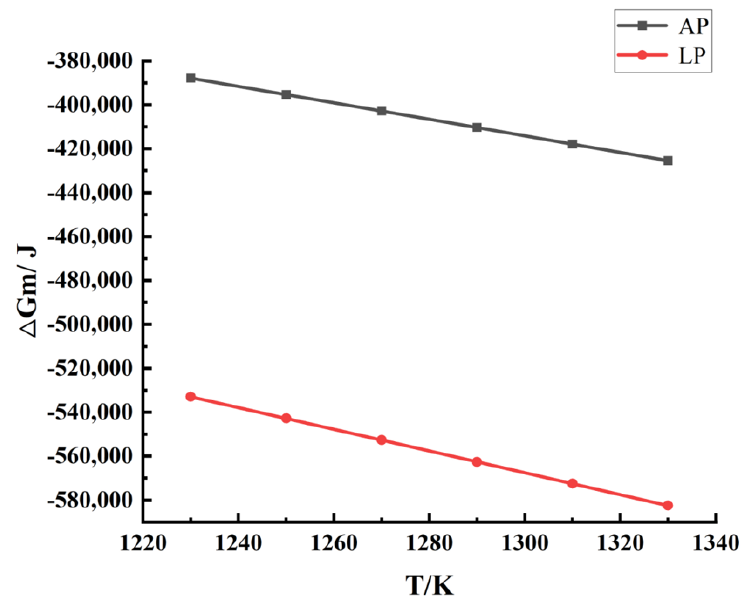
Figure 3. Molar reaction enthalpy of methane decomposition at different temperatures.